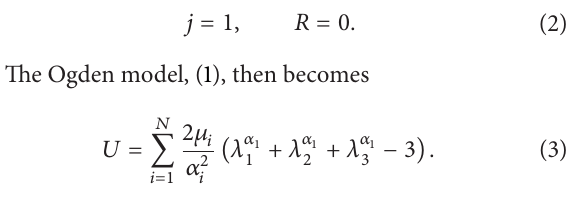
Figure 1: Typical steps in parameters identification